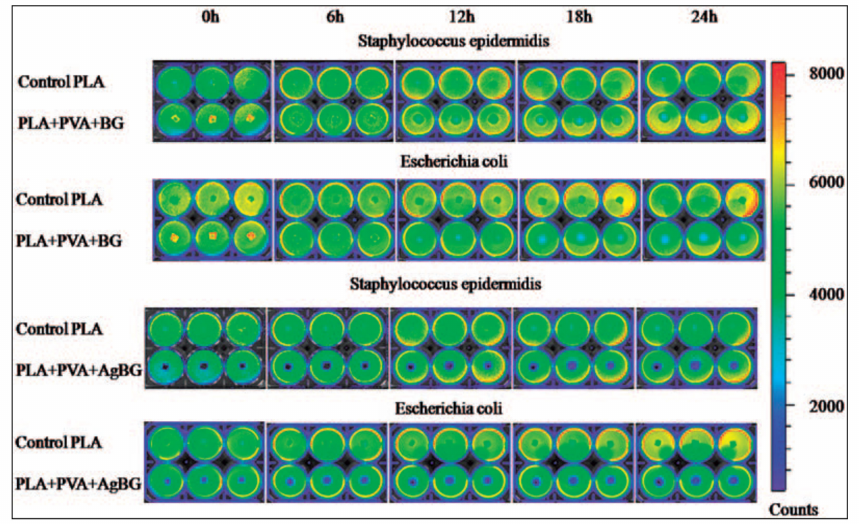
Figure 6. Bioluminescent signals from Escherichia coli and Staphylococcus epidermidis in response to the presence of polymer/bioactive glass and polymer/bioactive glass with Ag 2 O composites. (Reproduced with permission from Reference [114] published by